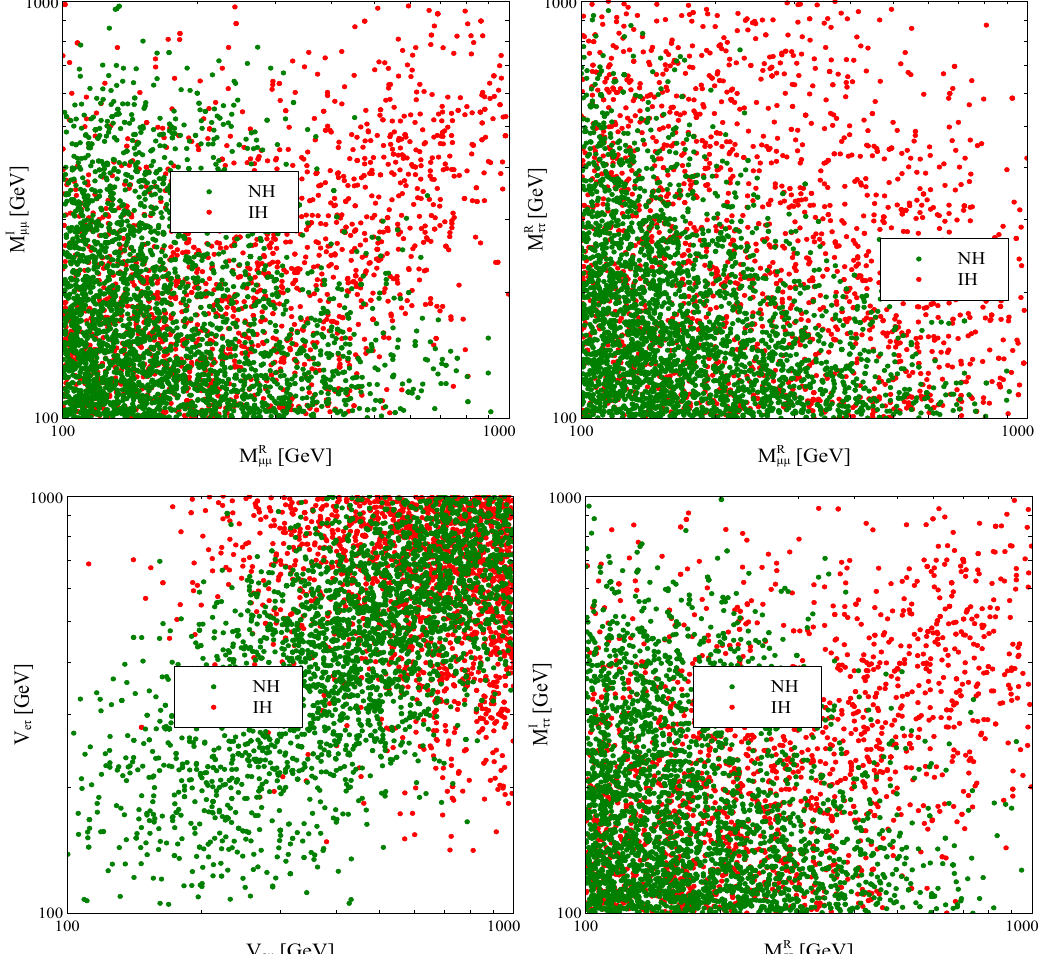
Figure 4 . Each point satis(cid:12)es neutrino oscillation data and both the allowed regions for NH and IH are overlapping on each other. Similar to (cid:12)gure 3, here also all the parameters have been scanned over the entire ranges given in eq.